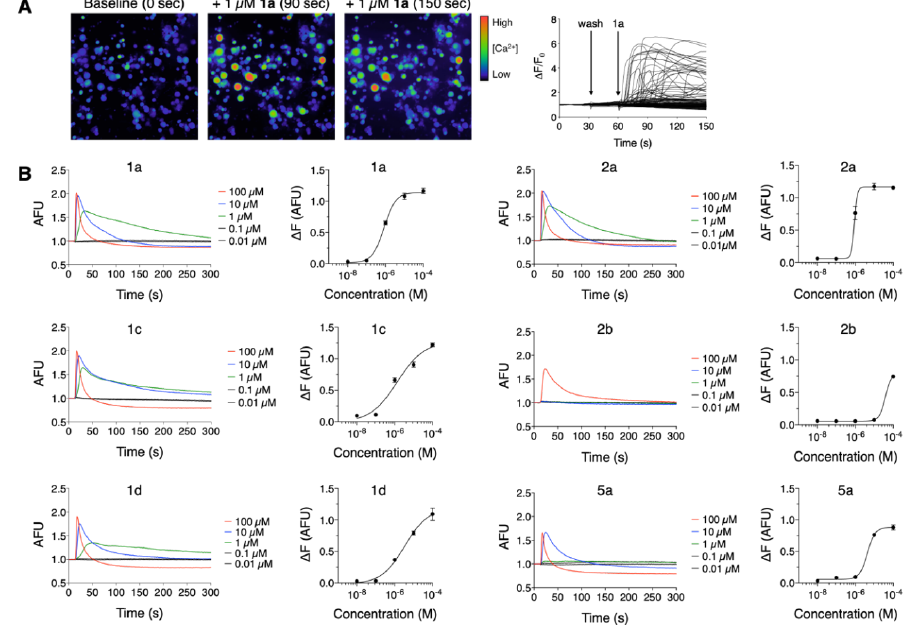
Figure 2. ( A ) Application of 1 µM Mp1a ( 1a) to dorsal root ganglion (DRG) cells induced a rapid increase in [Ca 2+ ] i followed by release of fluorescent dye into the media. The left panels (20x) show micrographs taken at baseline (0 s) and after addition of 1 µM 1a (synthetic Mp1a. at 90 and 150 s). The graph on the right (20x) shows fluorescence responses for individual cells within the field of view. ( B ) Fluorescence responses of F11 cells after addition of 1a – 1d , 2a , 2b and 5a over a range of concentrations (0.01–100 µM) recorded using a FLIPR. Changes in fluorescence (∆F) from the maximal response less baseline fluorescence were recorded ( n = 3) and used to generate concentration–response